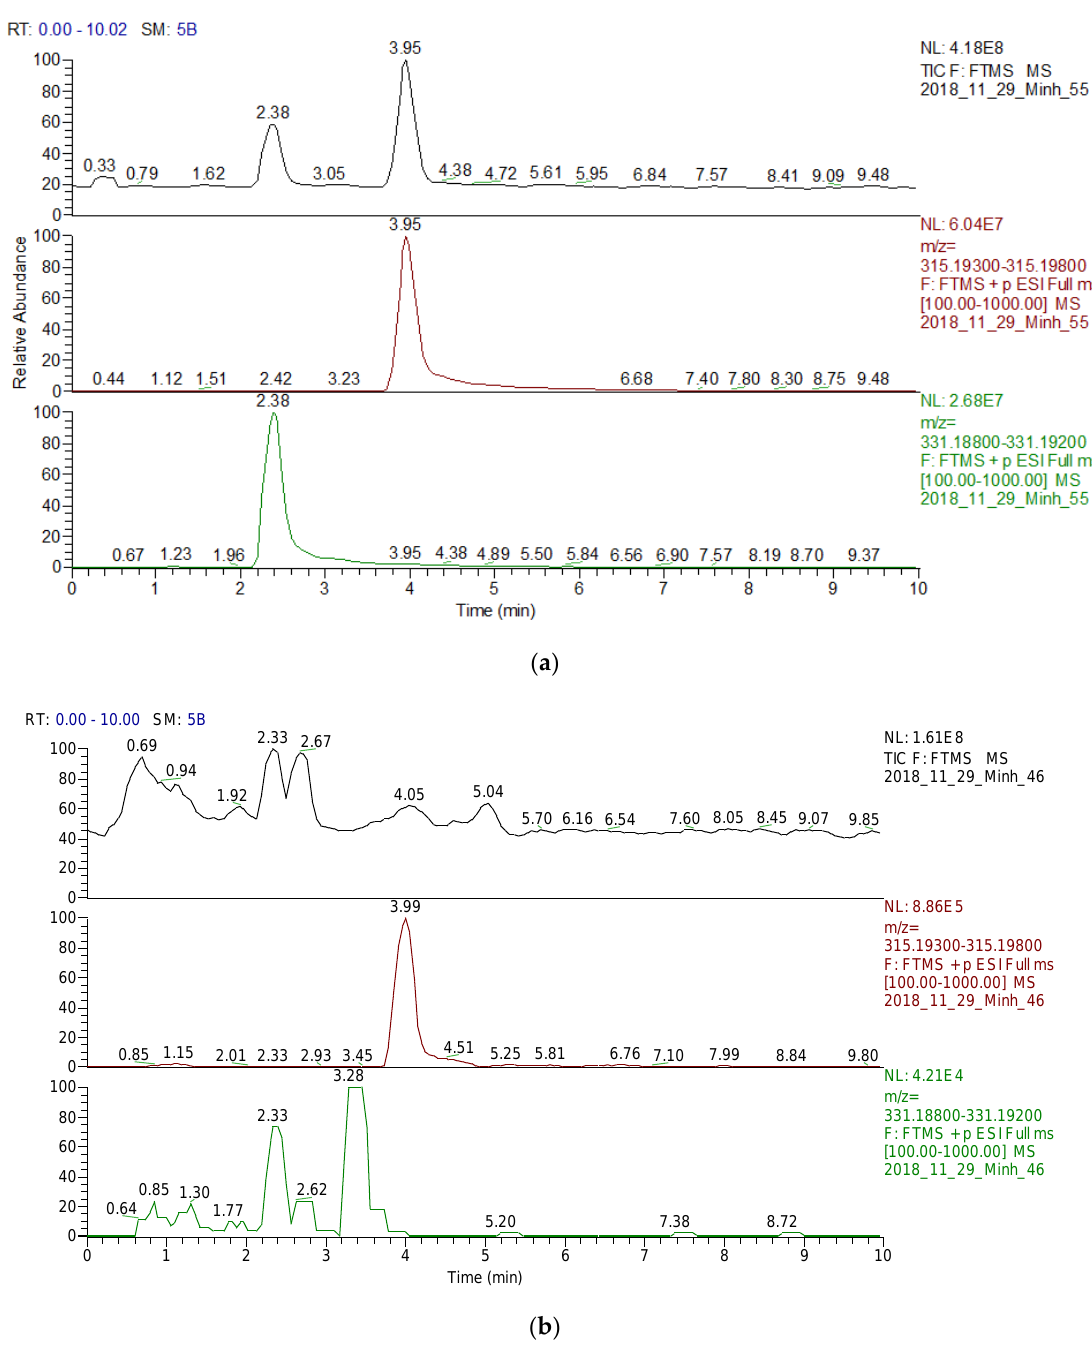
Figure 1. ( a ) UPLC/ESI–MS chromatogram of MA and MB (standard); ( b ) UPLC/ESI–MS chromatogram of MA and MB detected in rice leaf essential oil